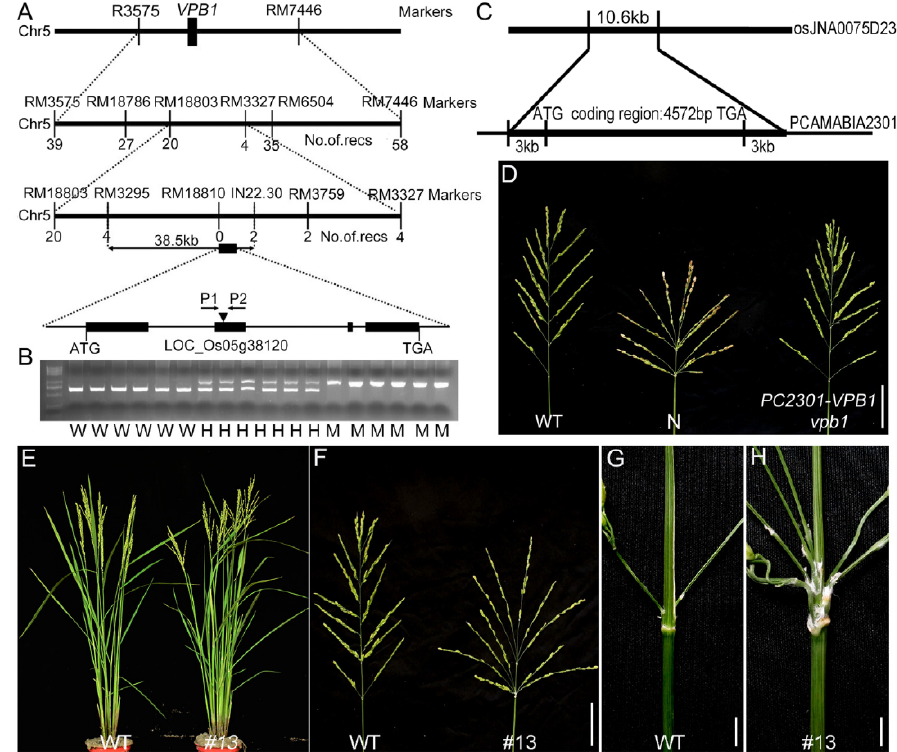
Figure 3. Positional cloning of the gene responsible for the vpb1 mutation. ( A ) Fine mapping of the VPB1 on chromosome 5. The VPB1 locus was narrowed to a ~38.5-kb genomic DNA region between markers RM3295 and IN22.30. recs is the number of recombinants. The structure of VPB1 , showing the mutation site of vpb1 . Closed boxes indicate the coding sequence, and lines between boxes represent introns. ( B ) Cosegregation analysis of a F 2 population derived from a cross of vpb1 x WT (ZH11) via PCR using the primers (P1, P2) shown in ( A ). M: mutant; H: hetero; W: wild type. ( C ) Schematic diagram of the pC2301- VPB1 construct. ( D ) Genetic complementation of vpb1 . N indicates negative control. Scale bar, 4 cm. (E-H) Performance of VPB1 positive and negative transgenic plants generated using the CRISPR/Cas9 strategy. ( E ) Mature wild-type plants (left) and the #13 mutant (right). ( F ) Mature panicles of wild-type (left) and #13 mutant (right). Scale bar, 4 cm. ( G , H ) Close-up view of the branch site of the primary branches in wild-type ( G ) and #13 mutant ( H ). Scale bar, 2